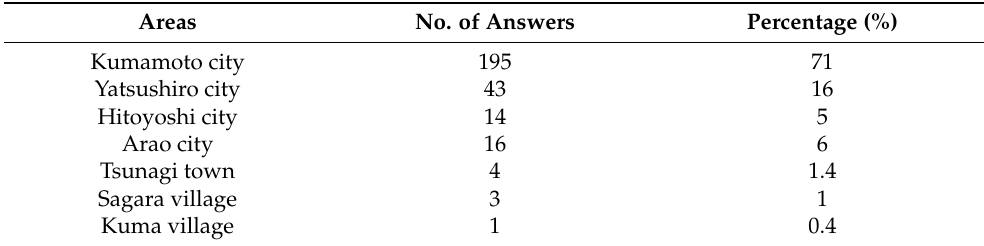
Table 2. Target areas of the survey. Areas No. of Answers Percentage (%) Kumamoto